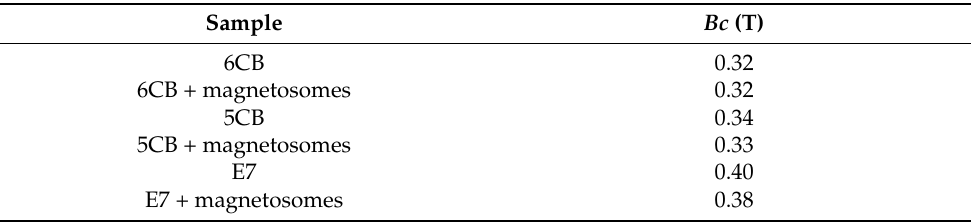
Table 1. The threshold magnetic fields of pure liquid crystals and liquid crystals doped with magnetosomes measured in 20 µ m cells.